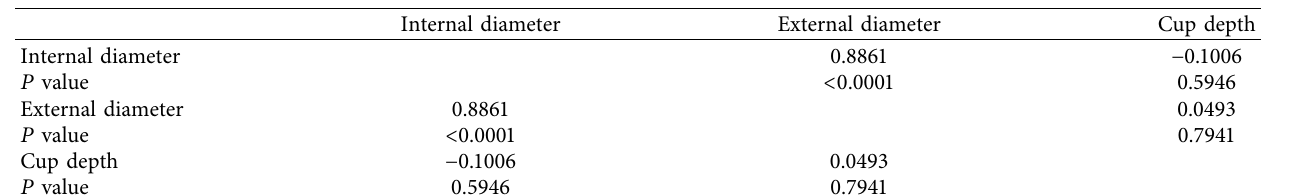
Table 1: Correlations among nest dimensions of the Blackbird.